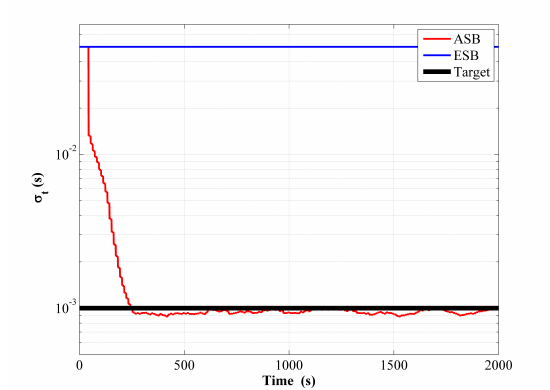
Figure 5. Estimated measurement noise of the ESB and the ASB algorithms using simulation data with unknown R k